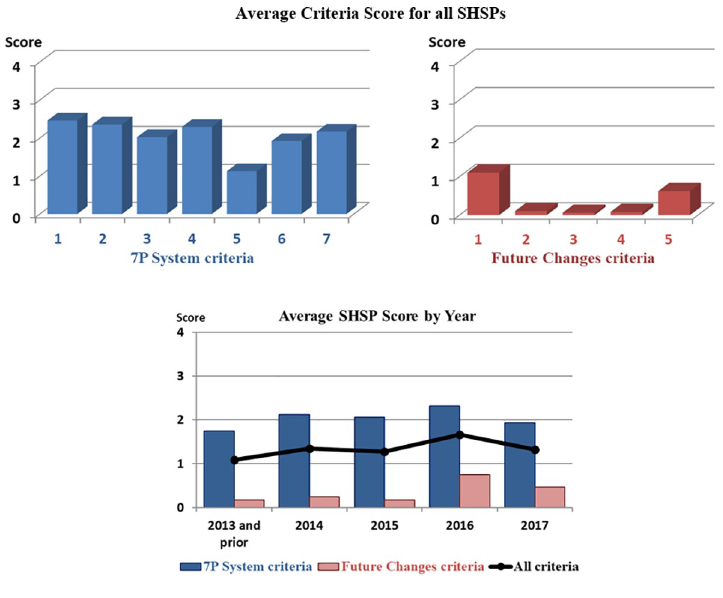
Fig 3. Average scores for SHSP